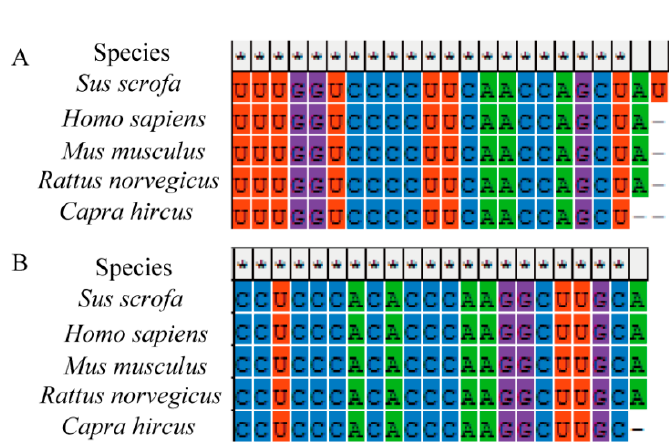
Figure 7. Conservative analysis of miR-133b ( A ) and miR-532-3p ( B ). 3.7. Detection of Target Genes Expression of Diarrhea-Resistant miRNAs 3.7. Detection of Target Genes Expression of Diarrhea-Resistant